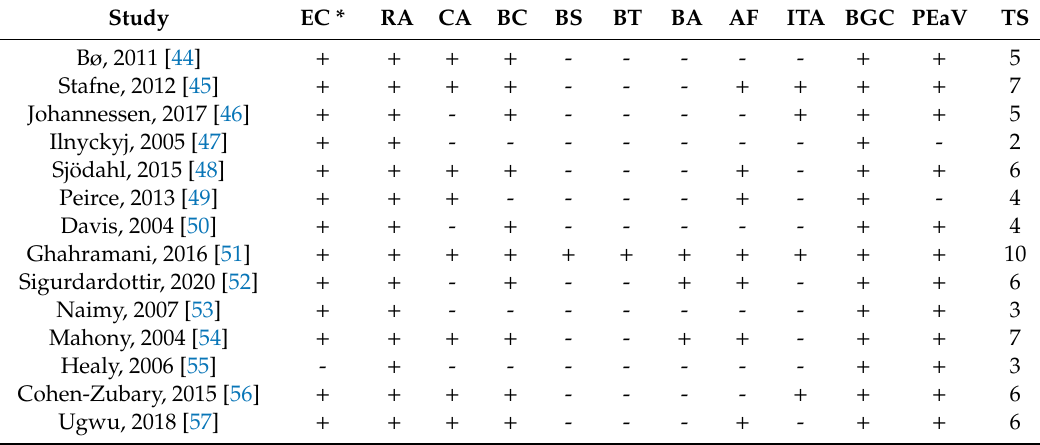
Figure 1. PRISMA diagram presenting the different phases of the systematic review. Table 2. Evaluation of the quality of research in Pedro scale included only RCT studies [43].